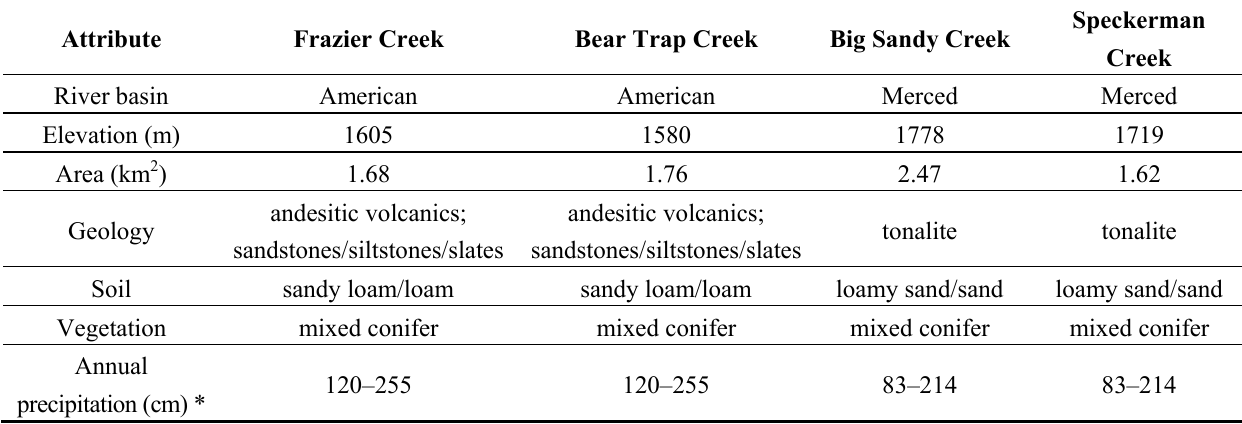
Table 1. Study watershed